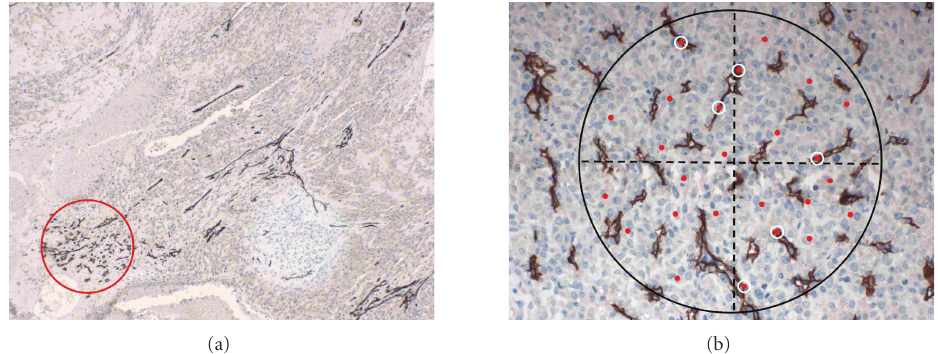
Figure 2: (a) Low-power view of a histologic section from an osteosarcoma, showing a microvascular hot spot in the lower left corner (original magnification: 40X). (b) Histologic section with the Chalkley graticule superimposed. The graticule, equipped with 25 stochastically spaced points, is rotated until the highest number of these 25 points coincides with immunohistochemically stained microvascular profiles in the tumor tissue. The mean of three hot spot counts is reported as the angiogenetic Chalkley number (immunohistochemical stain by CD34 to highlight endothelial cells and vascular profiles; original magnification: 200X).